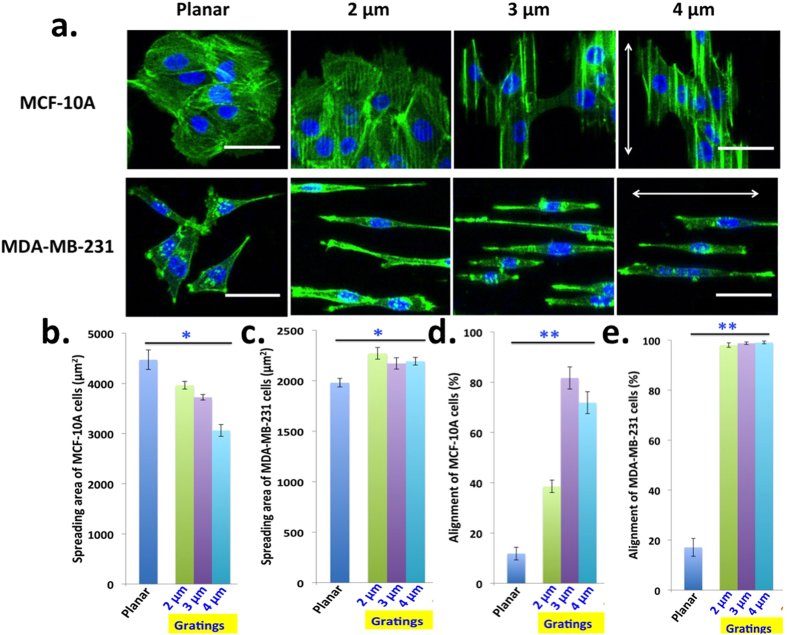
Microgratings reduces spreading area in MCF-10A but not in MDA-MB-231 cells.(a) Confocal microscopy representative images of the morphology of MCF-10A and MDA-MB-231 cells seeded on various topographic patterns. Double-sided arrow indicates the direction of the grating axis. (Phalloidin: Green; DAPI: Blue; Scale 50 μm). Spreading area of (b) MCF-10A cells and (c) MDA-MB-231 cells across various dimensions of microgratings. Spreading area decreases for MCF-10A but increases for MDA-MB-231 cells on microgratings. Alignment percentage of (d) MCF-10A cells and (e) MDA-MB-231 cells along the gratings. Both cells are aligned parallel to the microgratings. Data are means ± s.e.m. (n = 3). For each experiment, 200 cells were considered on an average. P values were obtained using Student’s unpaired t-test. **p < 0.01 and *p < 0.05 with respect to planar.